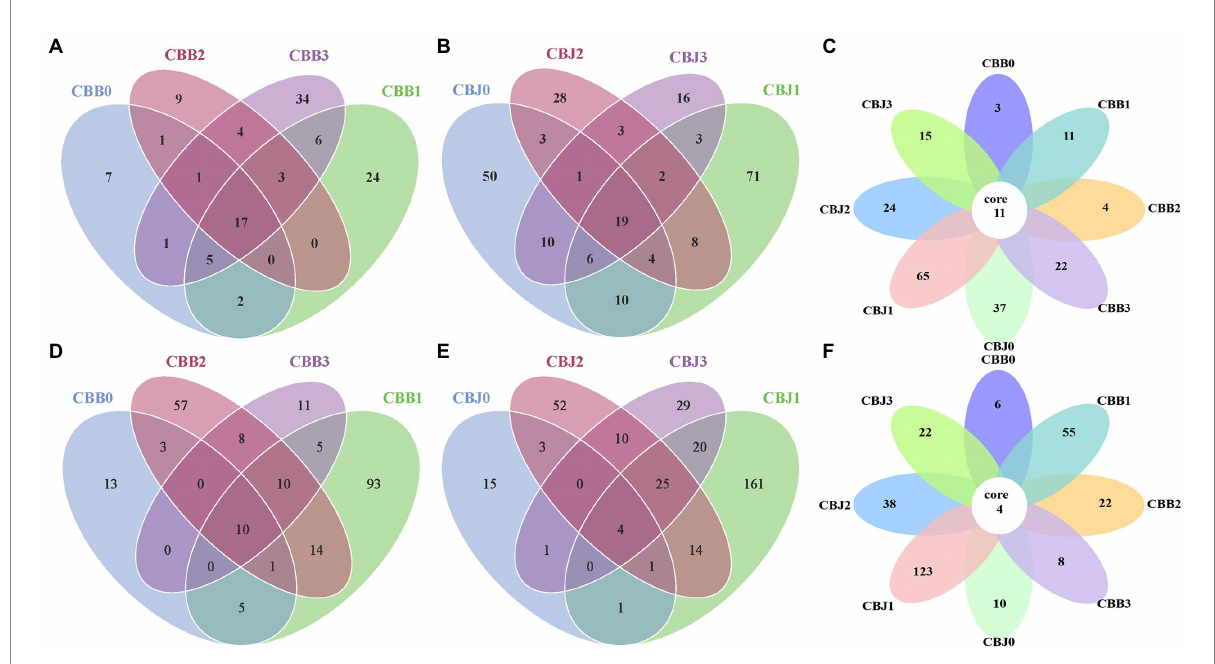
FIGURE 3 Venn diagram showing the number of microbial OTU detached in tobacco leaves (symptomatic leaves CBB; asymptomatic leaves CBJ) at four sampling time points (0–3). (A–C) for fungal, (D–F) for bacterial. Numbers in the non-overlapping region indicate unique OTUs for the single sample; numbers in the overlapping region indicate shared OTUs for multi-samples; and numbers in the core region indicate shared OTUs for each